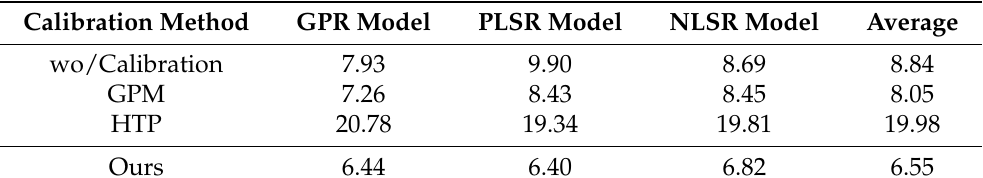
Table 4. Absolute mean error (degree) of cross-subject performance on different calibration methods. GPM: Gaussian process mapping, HTP: homography transform mapping.